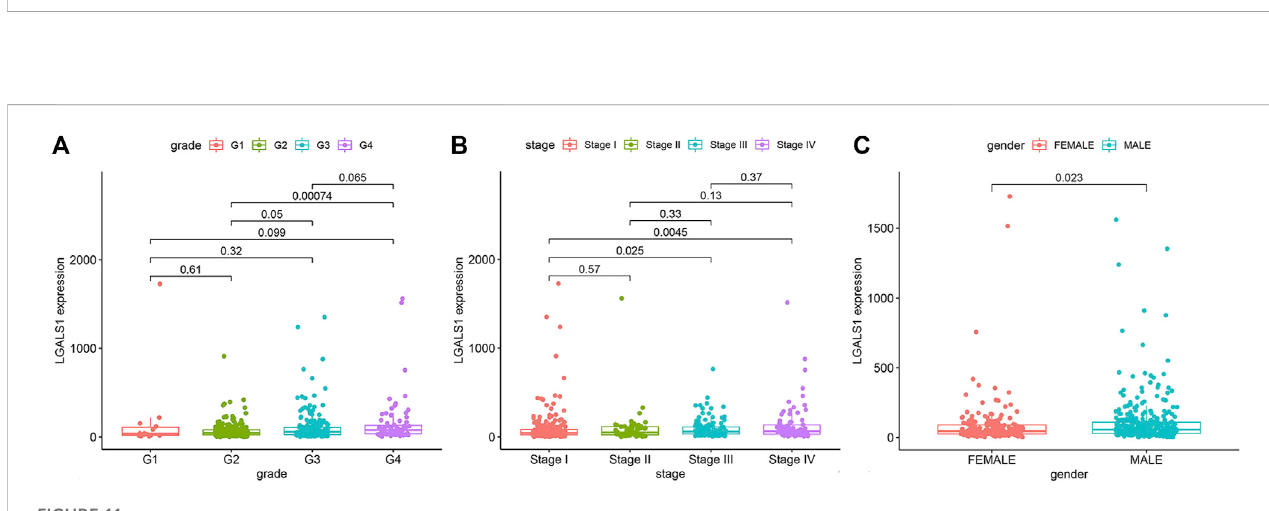
FIGURE 11 (A) Boxplotoftheassociation between theexpression ofLGALS1and Grade. (B) Boxplotoftheassociation between theexpression ofLGALS1and Stage. (C) Boxplot of the association between the expression of LGALS1 and